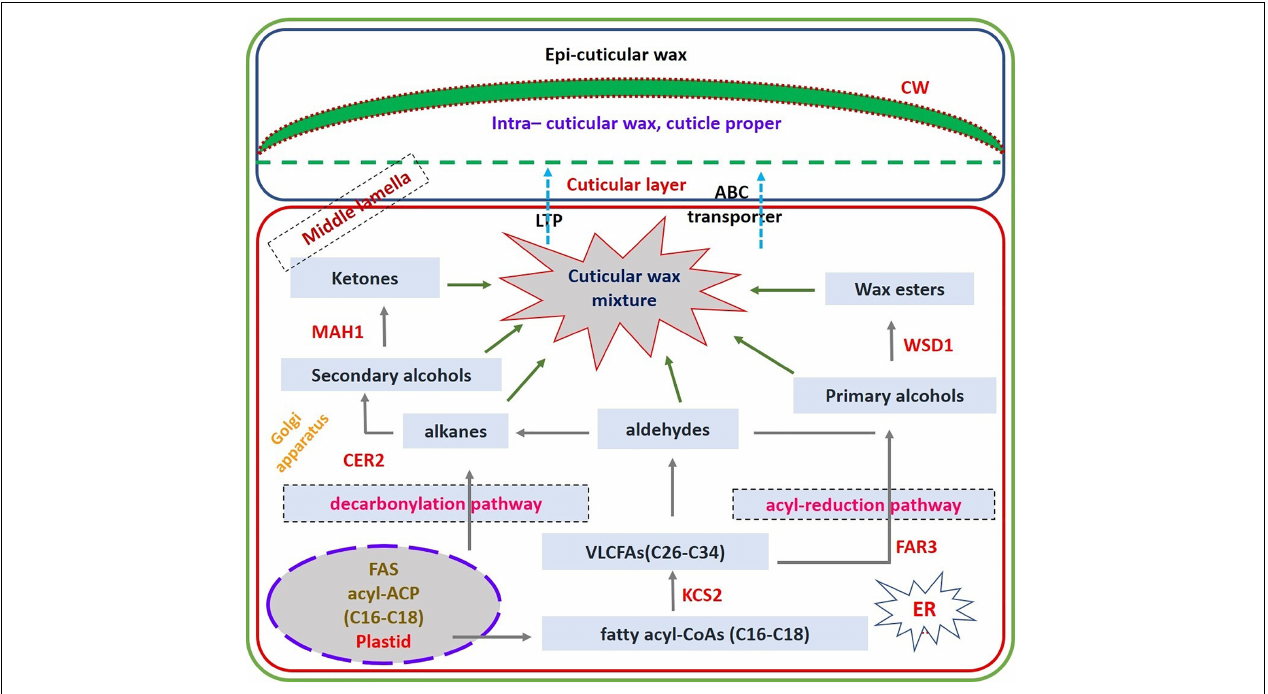
FIGURE 8 | Upregulated genes involved in Wax biosynthesis